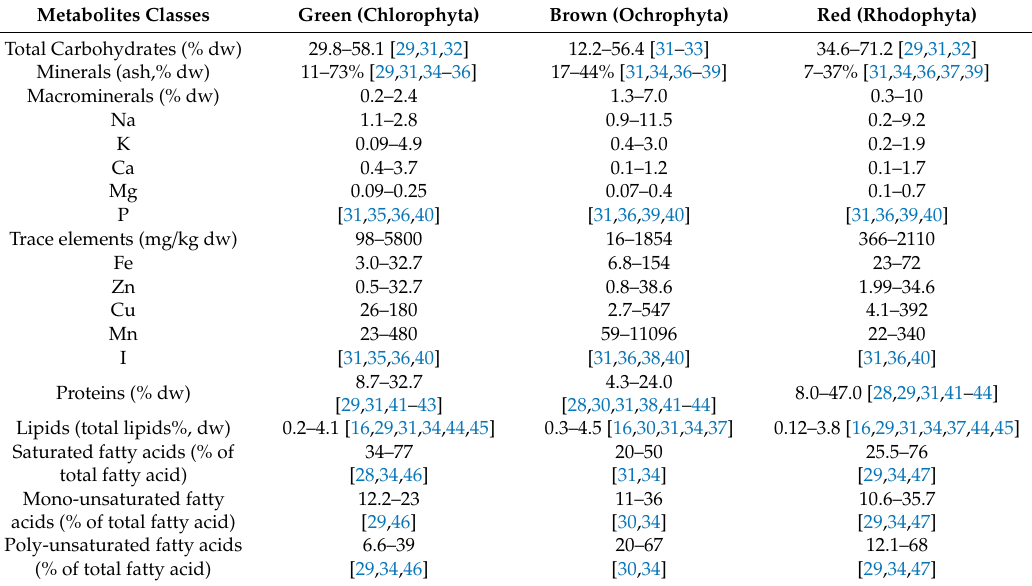
Table 1. Average content of each seaweed primary metabolite class and